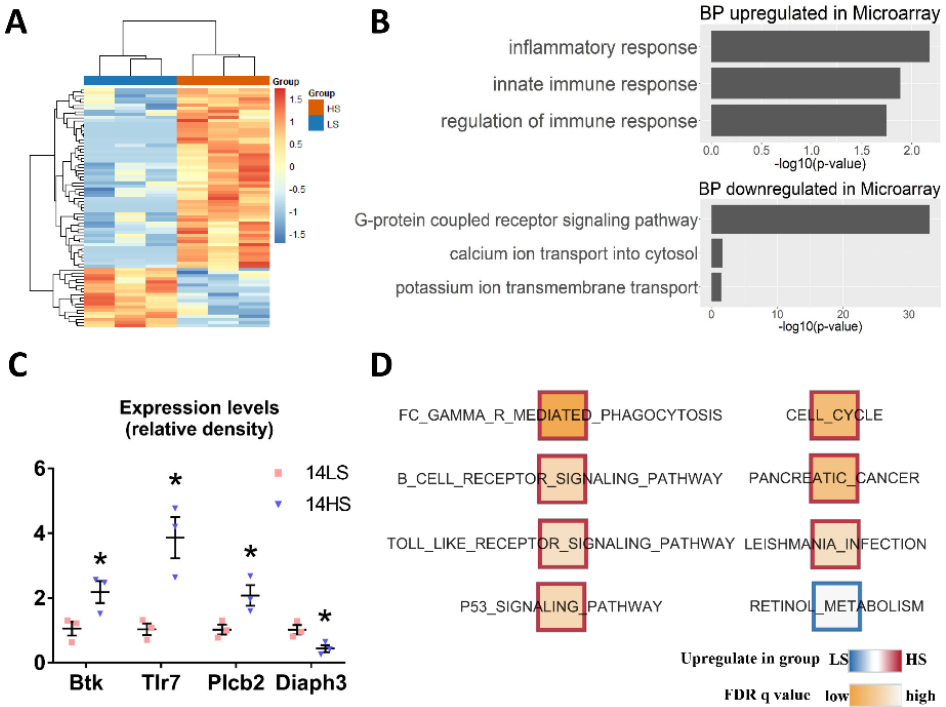
Figure 7. GO, GSEA, and real-time PCR analyses on the dysregulated genes identified by transcriptome. ( A ) Heatmap of the transcriptome, where hierarchical clustering of samples (columns) and genes (rows) is based on Pearson’s correlation coe ffi cient to measure the distance and the mean to cluster the samples. ( B ) GO Analysis of 465 significant downregulated and 142 upregulated genes. ( C ) Real-time PCR results showing expression levels of Btk, Tlr7, Plcb2, and Diaph3 in the two groups, where all data were normalized to Gapdh expression. Fold change for expression level comparison was calculated with 2ˆ(-ddCT). Primers are listed in Supplementary Table S1. * p < 0.05. ( D ) GSEA of all detected genes, where nodes represent significantly enriched ( p < 0.01, q < 0.05) gene sets of canonical pathways from the MSigDB. The colors of node borders refer to upregulated (red) and downregulated (blue) in HS group, while the node color represents the FDR